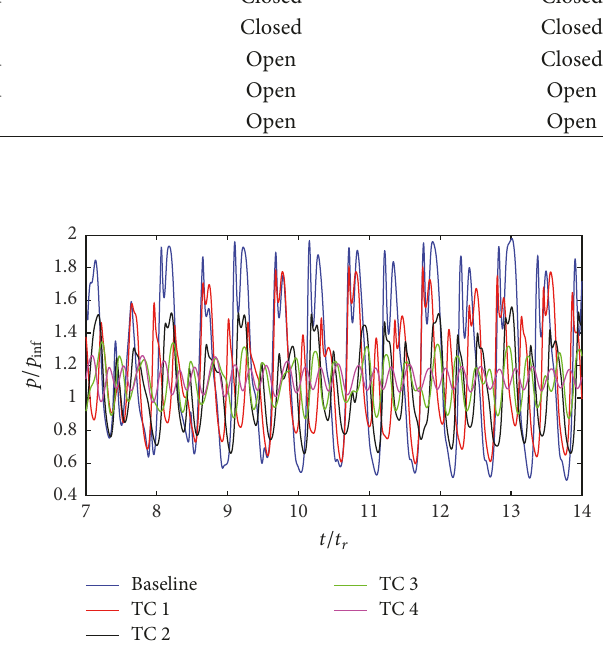
Figure 25: Pressure distribution for the control point for the cases with passive control with trailing edge wall